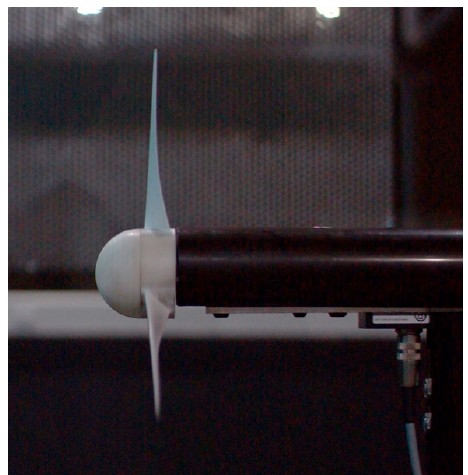
Figure 5. High-speed photography of a 3D-printed rotor deformed under operation at 3200 rpm.